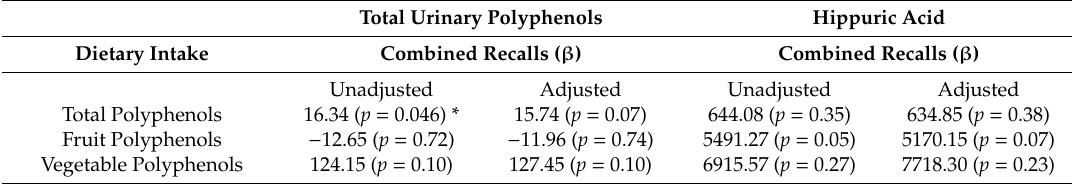
Table 2. Results of linear mixed model analyzes exploring relationships between total, vegetable and fruit polyphenol intakes and total urinary polyphenols and urinary hippuric